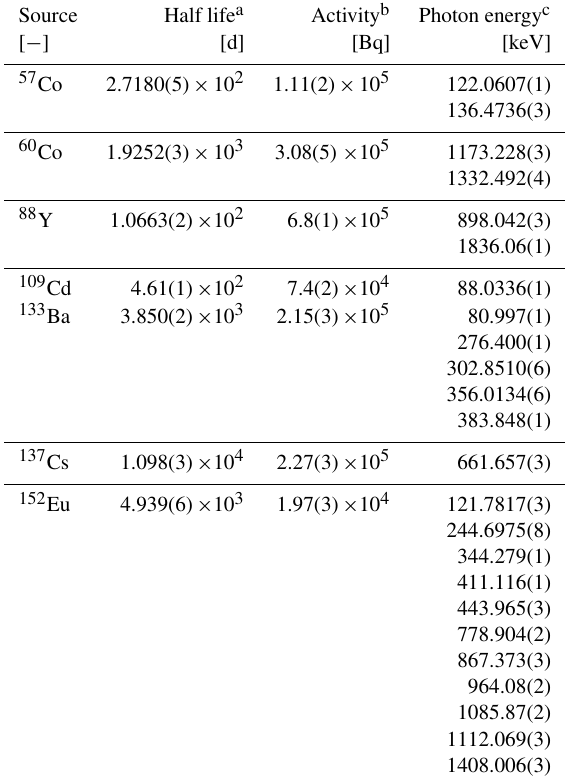
Table A1. Physical properties of the calibrated radiation sources adopted for detector characterization and simulation model valida- tion measurements. Uncertainty values are stated as 1SD values and provided as last significant figures, e. g. 0.12(3) corresponds to 0.12 ±